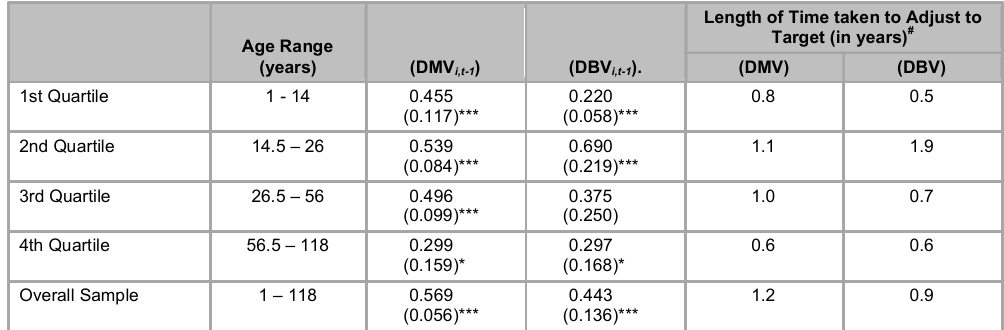
Adjustment speed of debt ratio across age